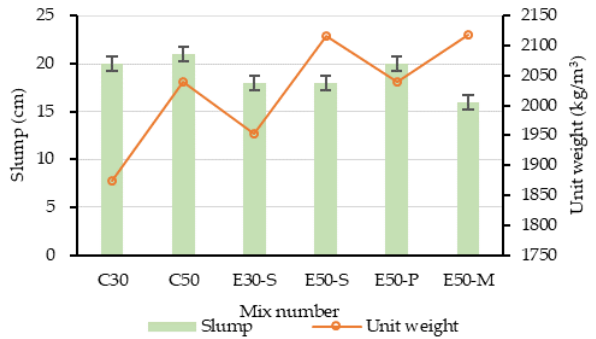
Figure 3. Results of slump and unit weight test of lightweight aggregate concretes.